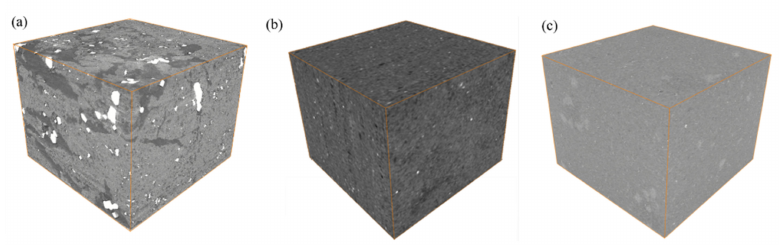
Figure 7. 3D digital cores of sample A ( a ), sample B ( b ), and sample C ( c